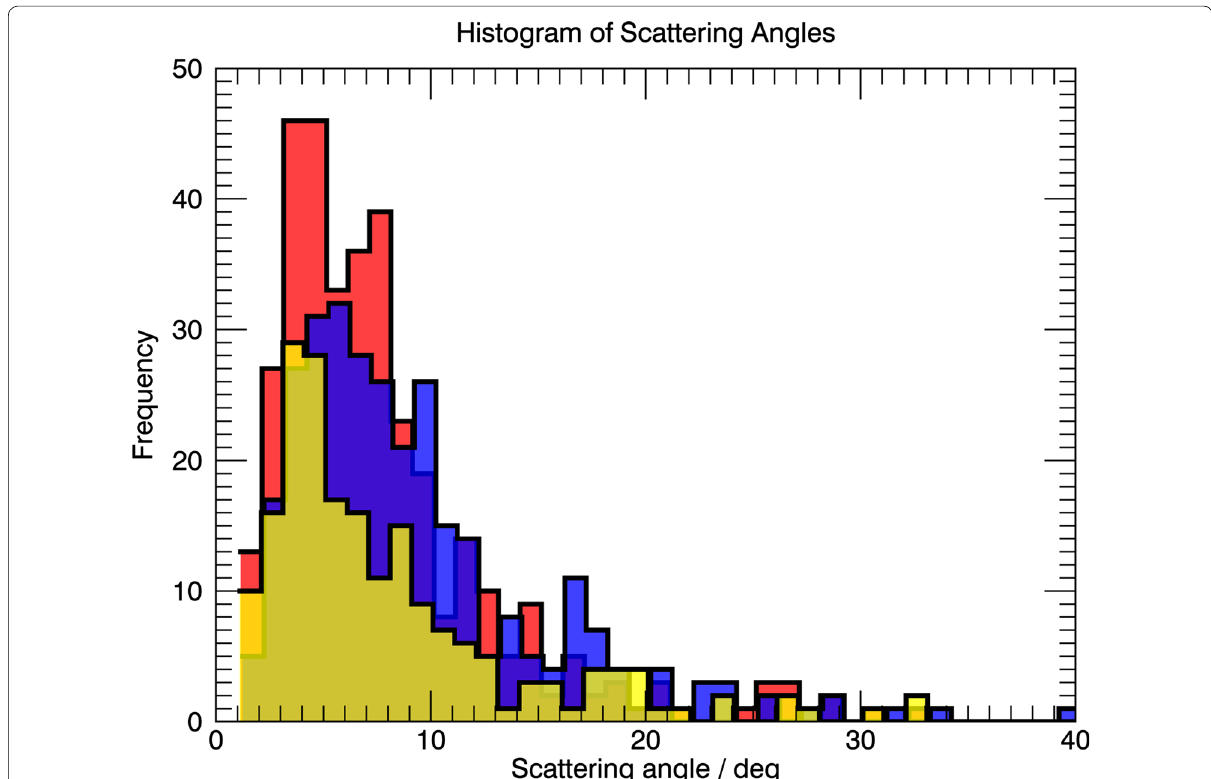
Fig. 5 Examples of the distribution of scattering angles for three heights: 83.1 km, yellow; 85.8 km, red; and 88.8 km, blue. The median values are 6.8°, 7.4° and 8.7°, respectively. These results represent the mean of 21-min averages. The number of values determined for each of these heights is 197, 348 and 302 from a possible 502 (39%, 69% and 60%,